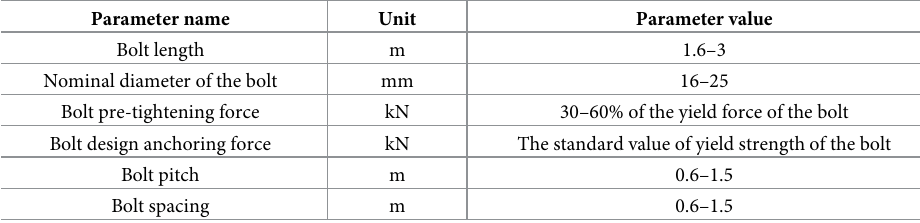
Table 3. Basic parameters of bolt support.